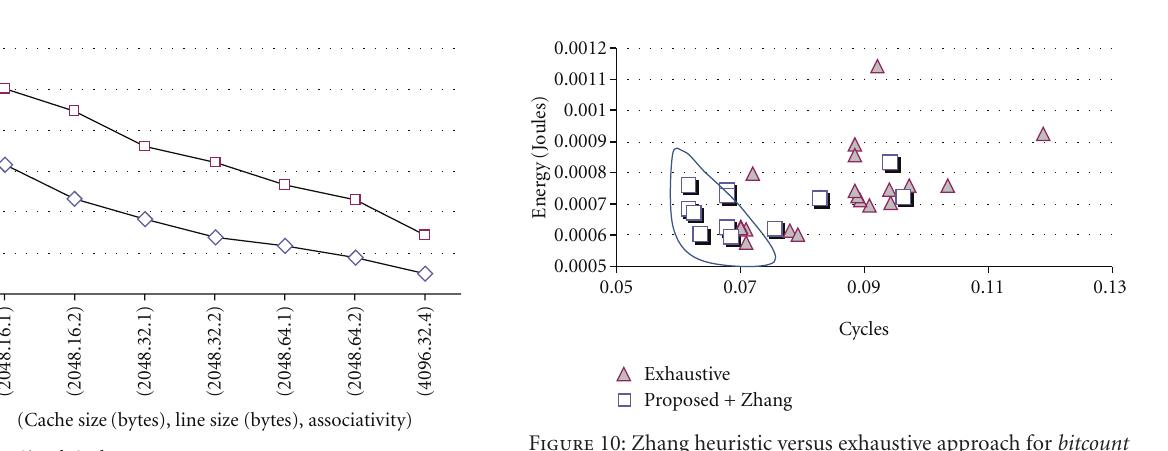
Figure 10: Zhang heuristic versus exhaustive approach for bitcount